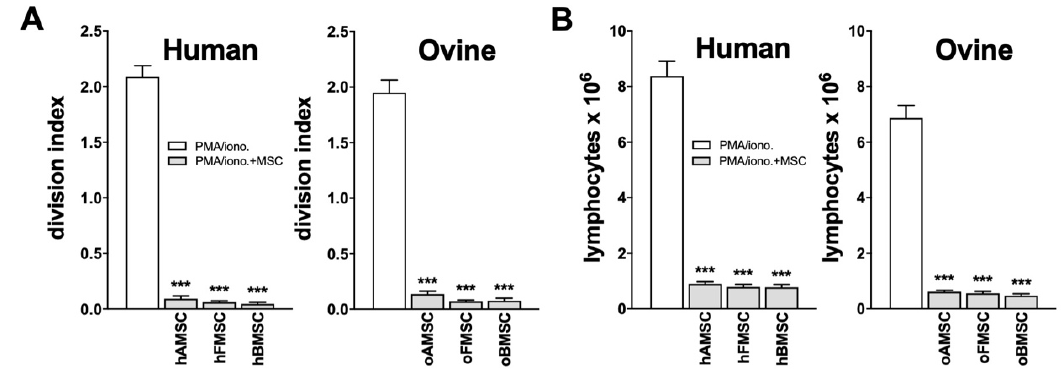
Figure 3. Immunomodulatory capacity of MSCs from human and ovine sources. Human and ovine MSCs from the three corresponding sources showed comparable immunomodulatory capacity by suppressing the proliferation of human and ovine lymphocytes, respectively. Carboxyfluorescein succinimidyl ester (CFSE)-labelled human and ovine lymphocytes were stimulated with PMA/ionomycin in the absence or presence of MSCs. ( A ) Calculations of division index and ( B ) total cell numbers of human and ovine lymphocytes are shown. Data are expressed as average ± SEM of 3-6 donors per source. *** p < 0.001, Mann–Whitney U test.